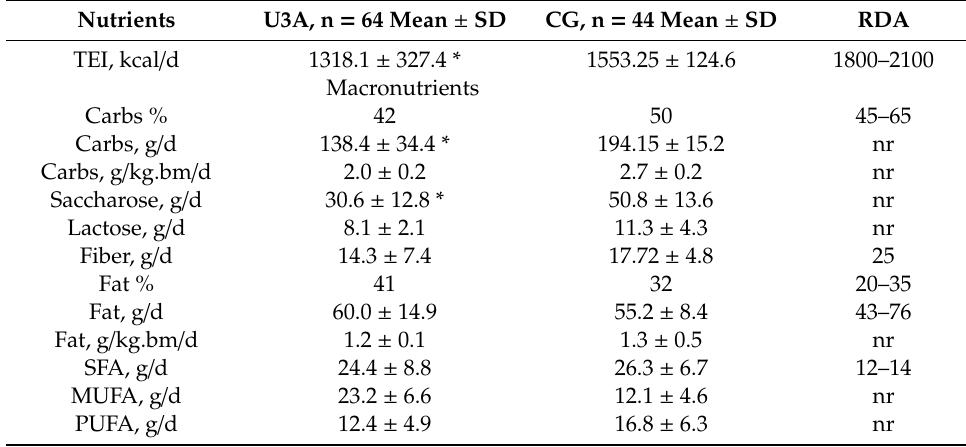
Table 2. Habitual energy intake, macronutrients, and vitamins and minerals consumption, as estimated from 7 day dietary records provided by